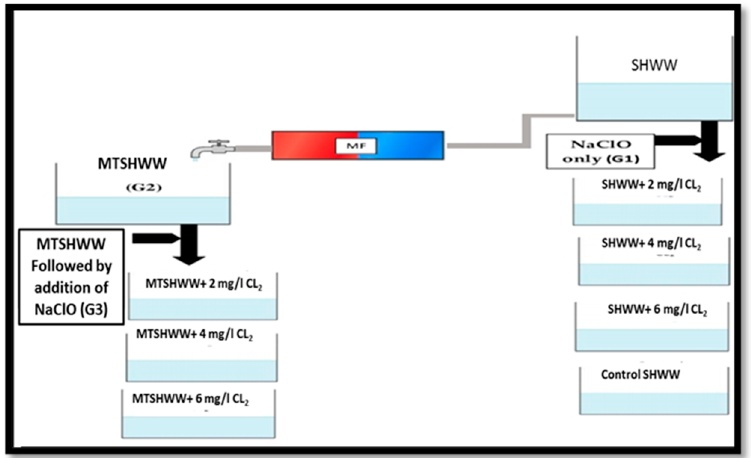
Figure 2. Study design: SHWW; slaughterhouse wastewater treated previously by sedimentation followed by coagulation using natural zeolite (1000 mg), then filtration through physically treated rice straw [19]. Different disinfection methods achieved treatment; G l ) 0, 2, 4, and 6 mg/L active chlorine; disinfection with 12% ( w / v ) commercial NaClO; G 2 ) MF: disinfection with magnetic field producing magnetically treated slaughterhouse wastewater (MTSHWW) and G 3 ) was pretreated with MF then NaClO at the exact chlorine dosages and MF strength.